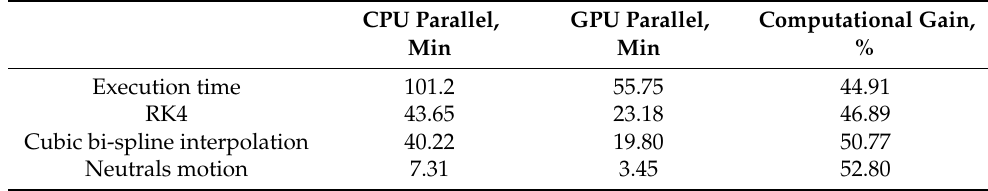
Table 2. Execution time comparison between the 3 different versions of the PIC